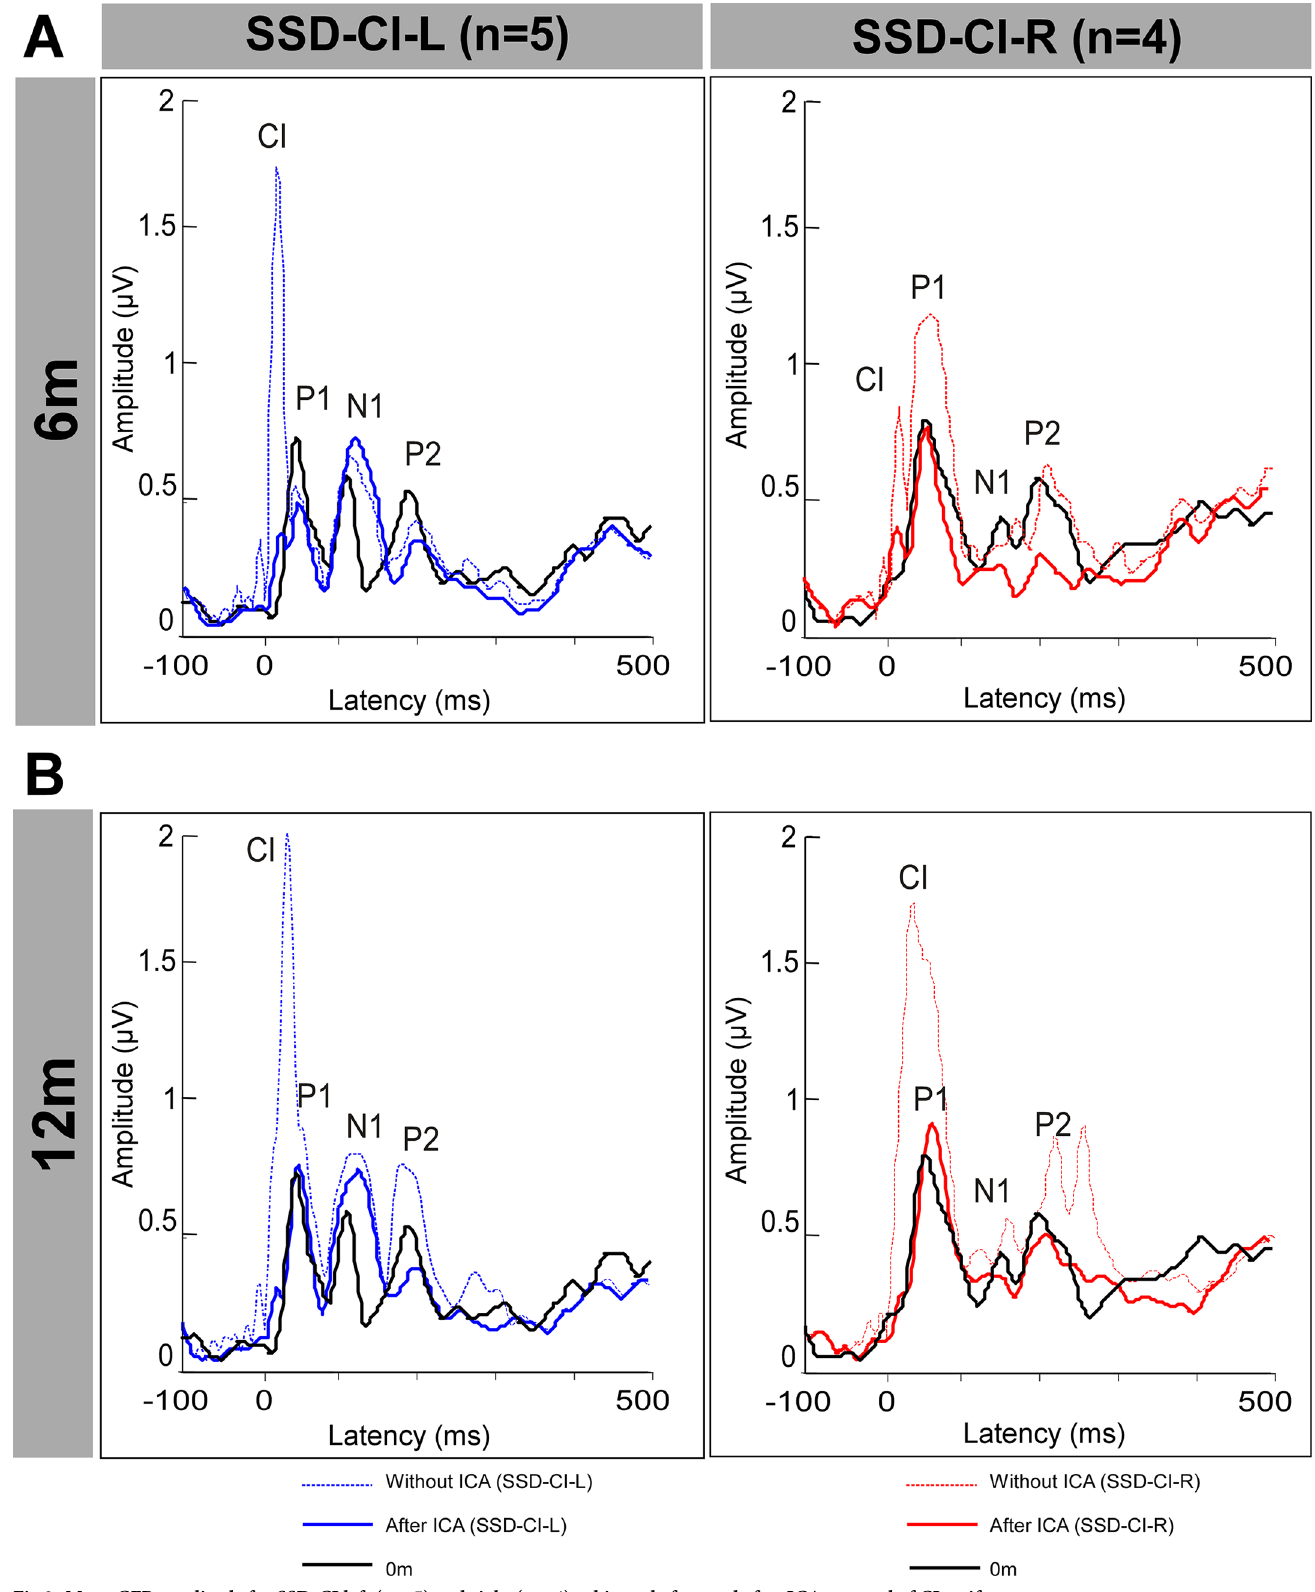
Fig 2. Mean GFP amplitude for SSD-CI left (n = 5) and right (n = 4) subjects, before and after ICA removal of CI artifact. https://doi.org/10.1371/journal.pone.0204402.g002 PLOS ONE | https://doi.org/10.1371/journal.pone.0204402 September 24,